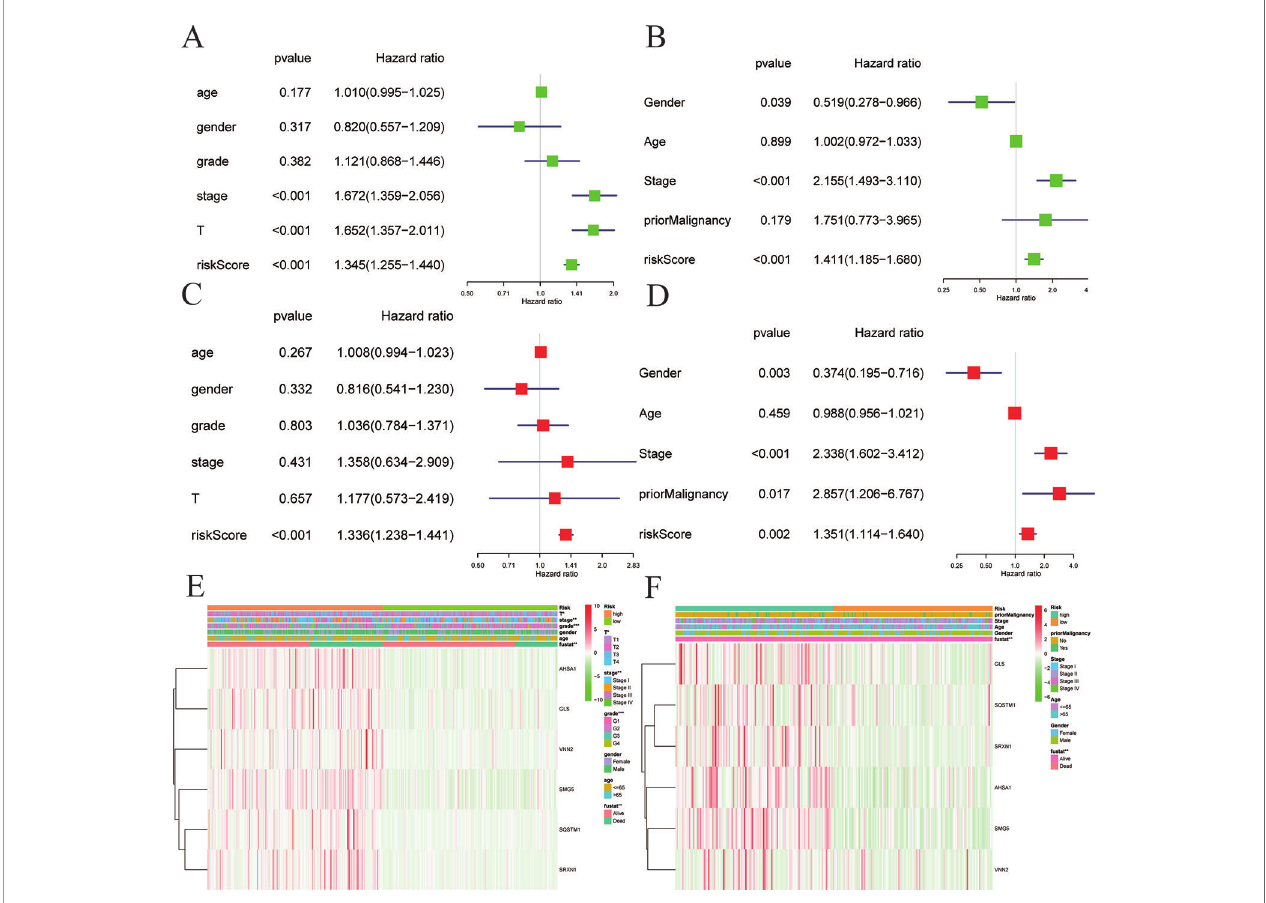
FIGURE 5 | Cox regression analyses of the association between clinicopathological factors and OS. (A – F) Univariate/multivariate Cox regression analyses and heatmaps of the association between clinicopathological factors (including the risk score) and overall survival (OS) of patients in the TCGA (A , C , E) and ICGC (B , D , F)